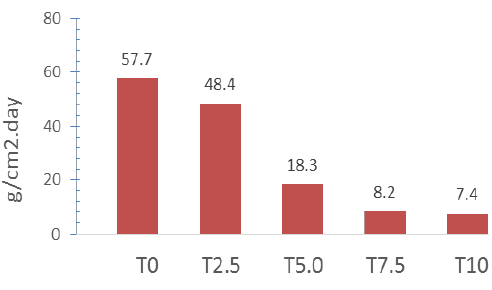
Figure 6. Weight loss of samples exposed to salt spray over the course of seven days.